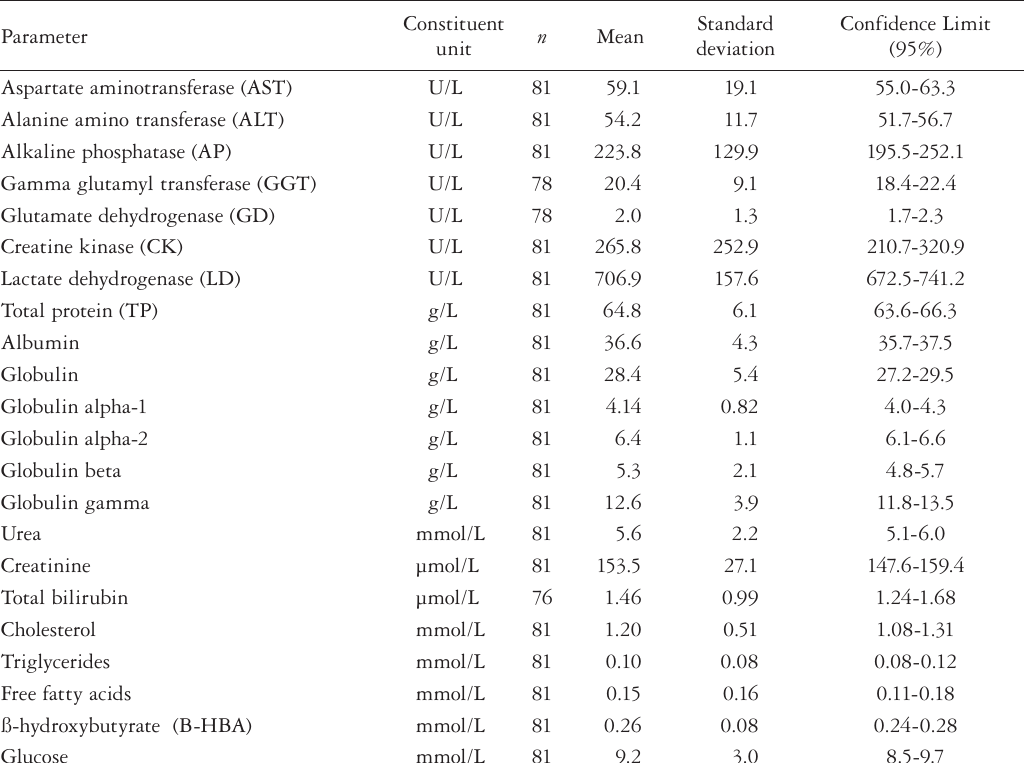
Table 2. Serum biochemical values in free-ranging red deer ( Cervus elaphus atlanticus ) immobilised with xylazine-tileta- min-zolazepam.